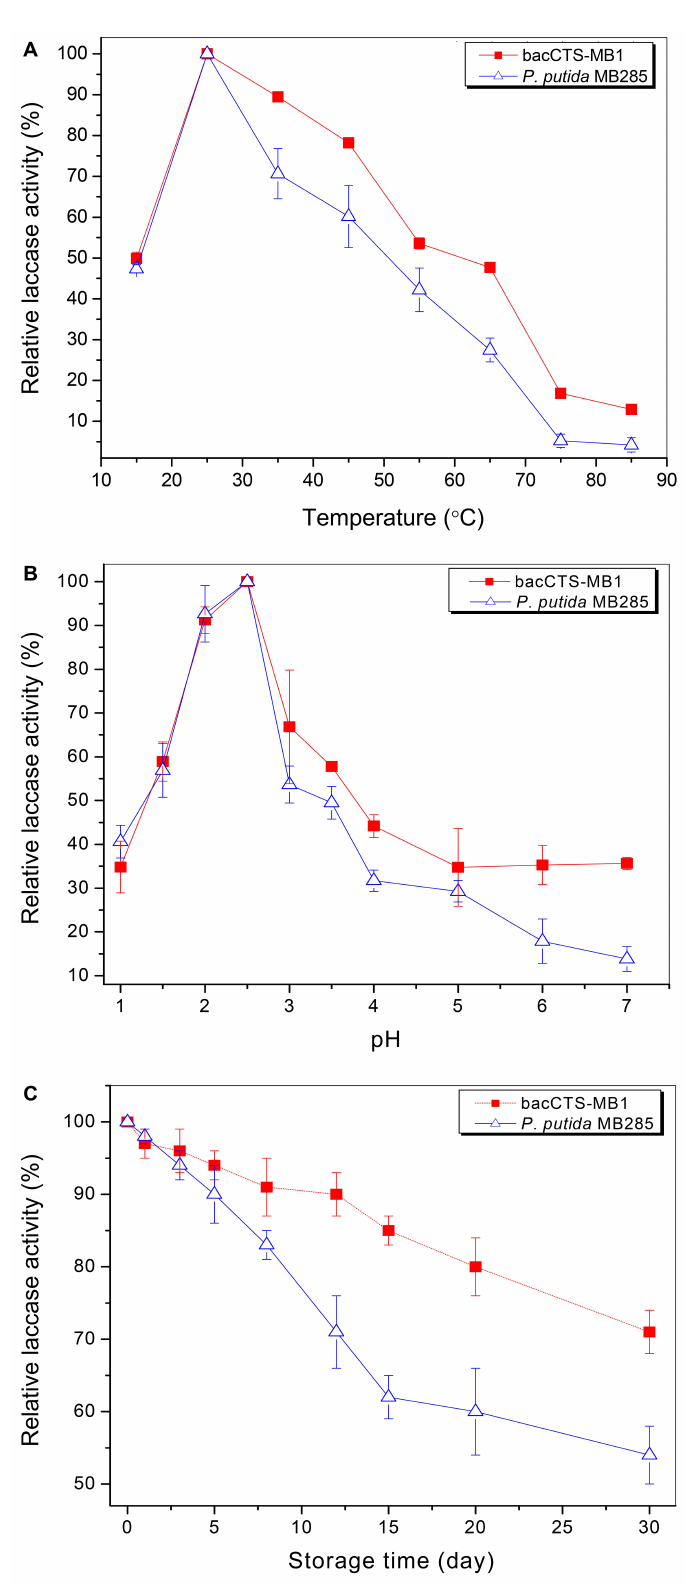
Figure 4. Effect of temperature ( A ), pH value ( B ) and storage time ( C ) on the whole-complex laccase enzyme activity of the bacCTS-MB1 complex. Whole-cell laccase enzyme activity of P. putida MB285 cells alone was assayed in